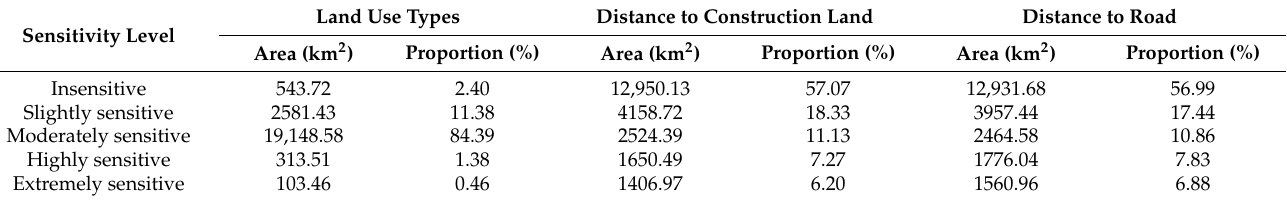
Table 5. Area and proportion of ecological sensitivity classification of human